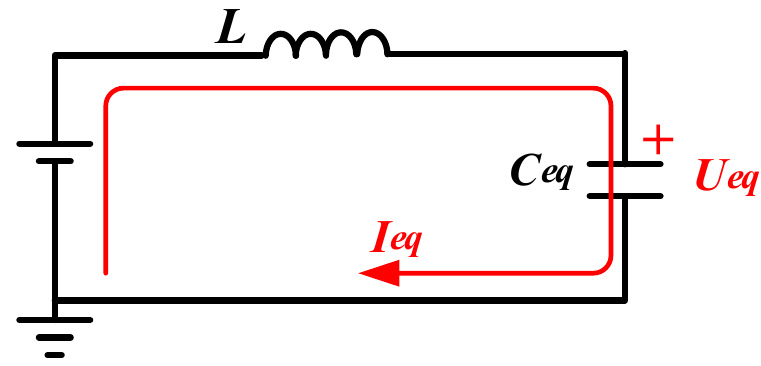
Figure 4. Capacitor charging mode equivalent circuit.